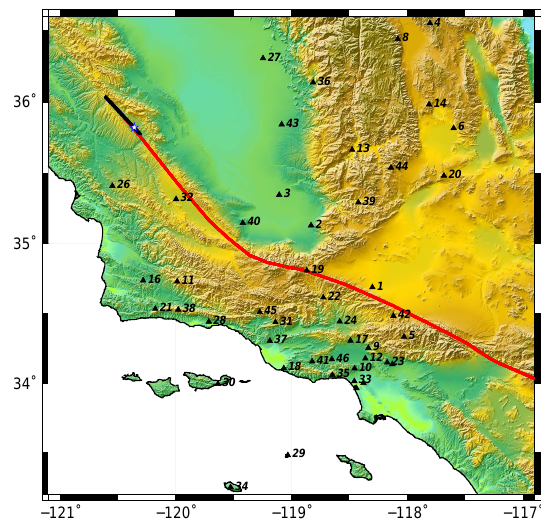
Figure 13. Location of all stations used in the 2004 Parkfield earthquake validation. Red line: Southern section of the San Andreas fault extending from Parkfield in central California to Bombay Beach in southern California. Black line: Trace/surface projection of the [51] earthquake source model. Star: Epicenter. Black triangles: Stations.